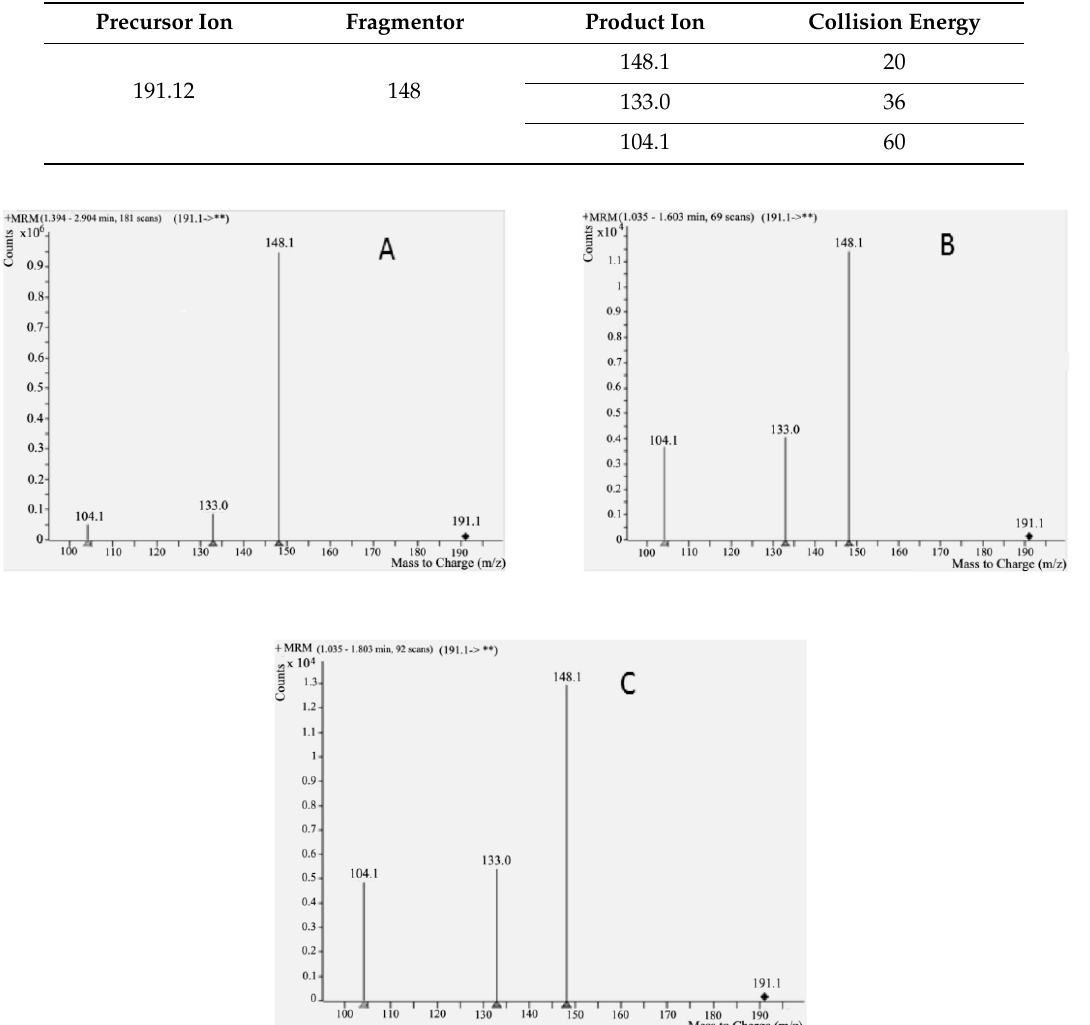
Table 3. LC-QqQ MRM transition parameters for the cytisine.